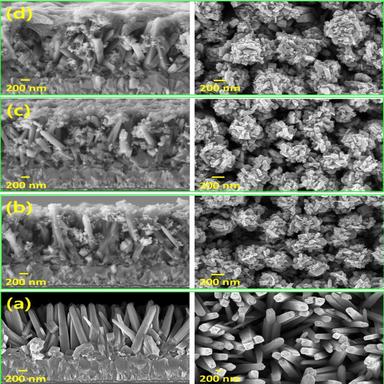
Top and cross-section FESEM images of (a) bare TONR/FTO, (b) (×3)-CdIS/TONR/FTO, (c) (×4)-CdIS/TONR/FTO, and (d) (×5)-CdIS/TONR/FTO.